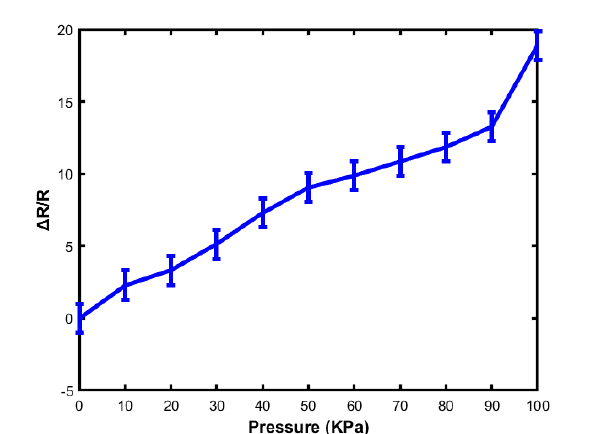
Figure 9. The relative change of resistance with respect to applied pressure.